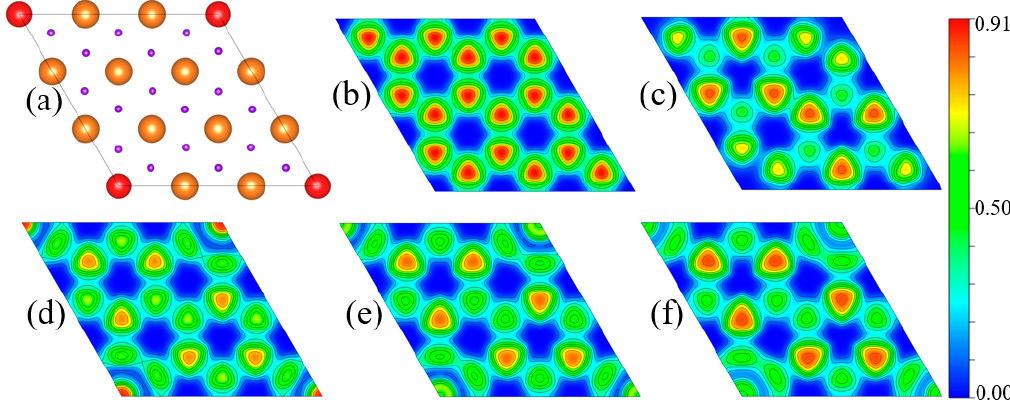
Figure 5. ( a ) Structural representation of considered systems. The big (small) ball represents Mg (H) and the red ball site is the doped site; ( b – f ) represent the electron localization function (ELF) of Mg 9 H 18 , Mg 8 H 18 , Mg 8 H 18 Ti, Mg 8 H 18 V, and Mg 8 H 18 Mn, respectively. The color bar represents the values of ELF.